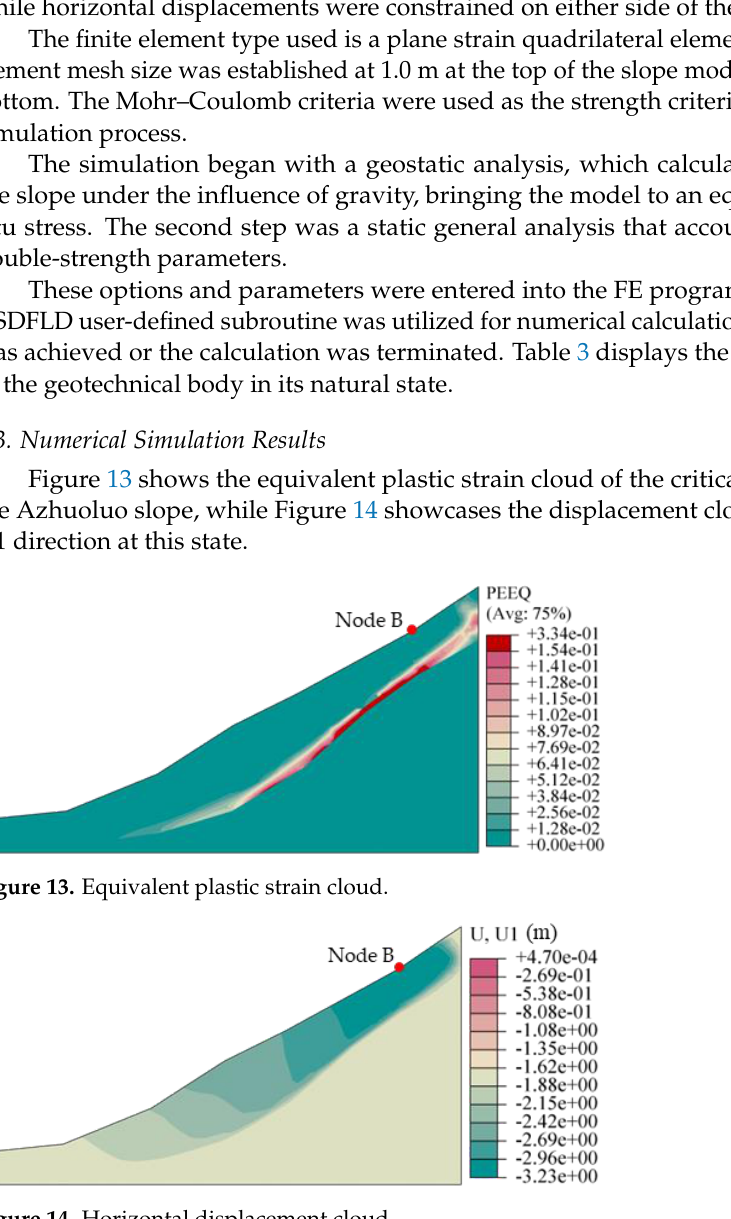
Figure 14. Horizontal displacement cloud.